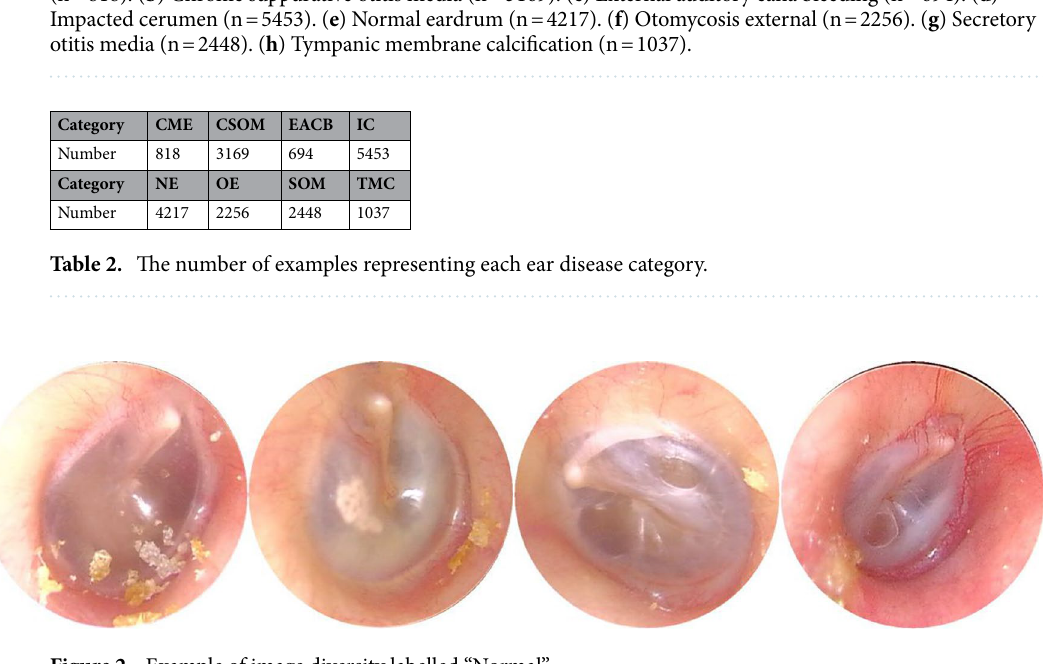
Figure 1. Otendoscopy image and eight diagnostic classes of ear diseases. ( a ) Cholestestoma of middle ear (n = 818). ( b ) Chronic suppurative otitis media (n = 3169). ( c ) External auditory cana bleeding (n = 694). ( d )